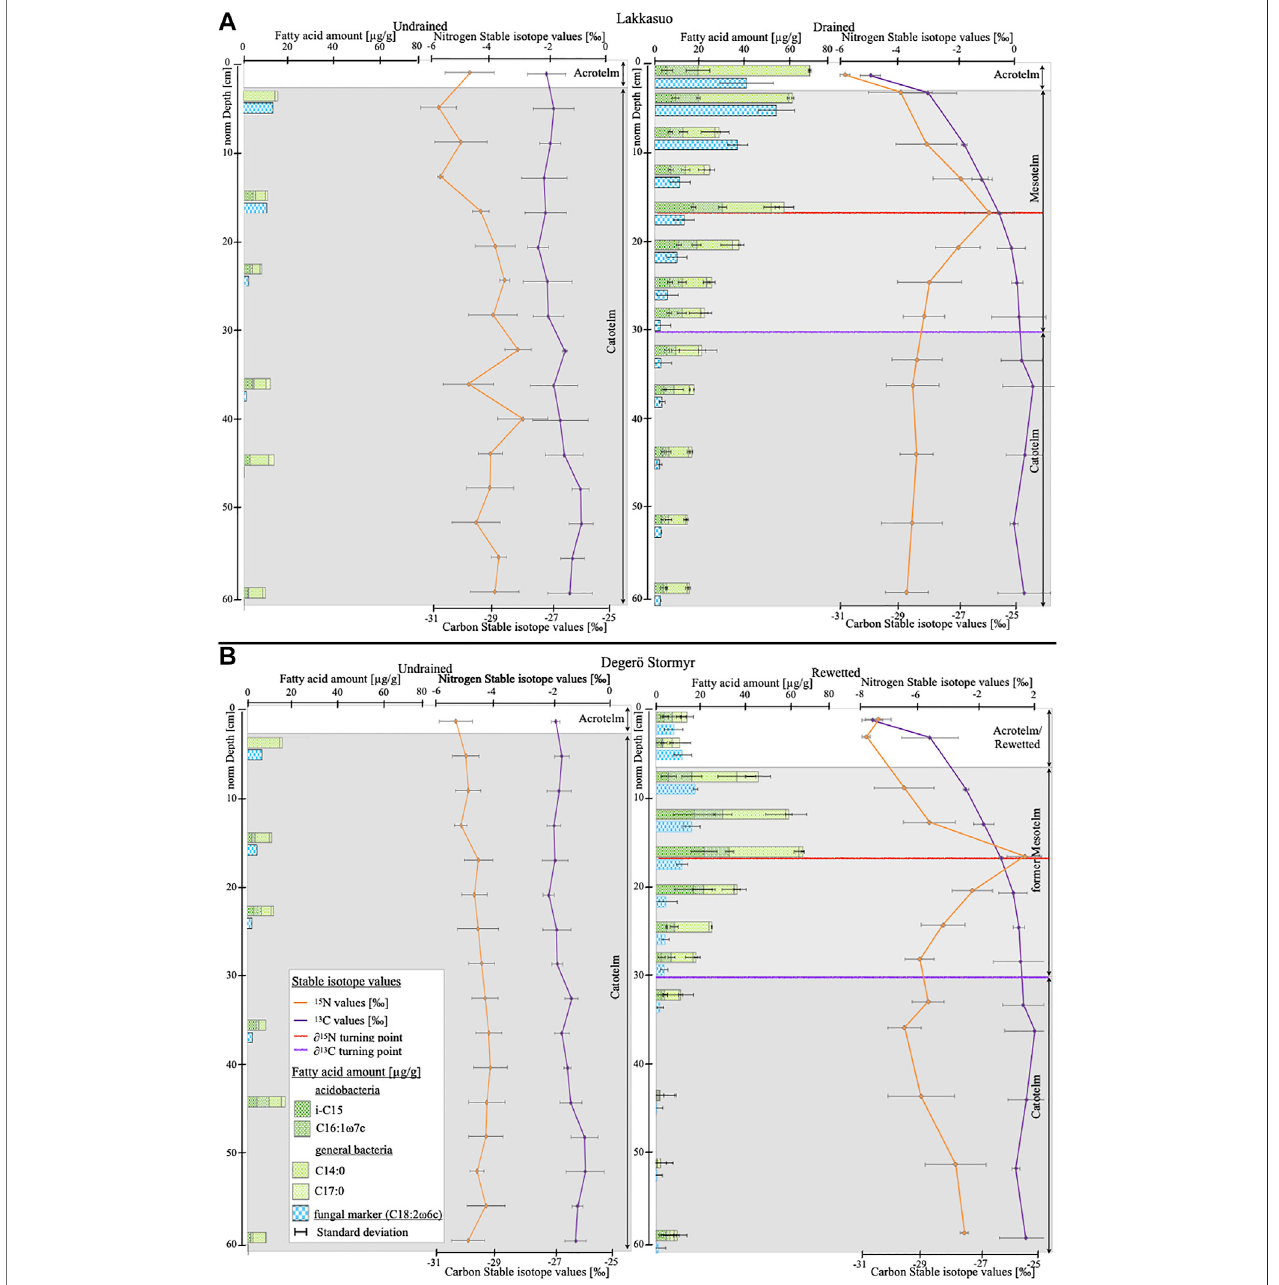
FIGURE 2 | Stable isotope depth trends [ ‰ ] (orange: δ 15 N, violet: δ 13 C) and fatty acids marker concentrations [µg/g], separated by different microbial groups (A) Lakkasuo:undrained